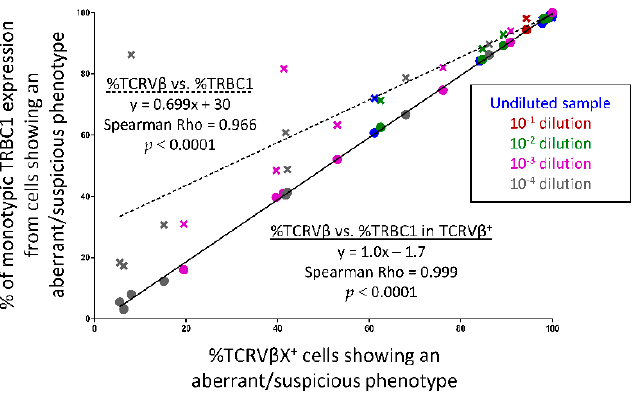
Figure 4. Sensitivity of the TRBC1 marker for detection of clonal T αβ -cells in serial dilutional experiments of clonal tumor cells in normal blood cells. Scatter plot showing the correlation between the percentage of TCRV β + vs. TRBC1 + cells (crosses and dotted line) and between the percentage of TCRV β + vs. (TRBC1 + and TCRV β + ) clonal cells (circles and solid line) within a specific T-cell population showing an aberrant/suspicious phenotype for both undiluted (total) samples and serially diluted (from 10 − 1 to 10 − 4 ) samples. TCRV β X refers to any of the specific (clonal) TCRV β family expressed by each case (e.g., TCRV β 22). For each correlation, the estimated linear regression equation, the Spearman’s Rho correlation coefficient and the corresponding p -values are shown (based on 8 dilution experiments).